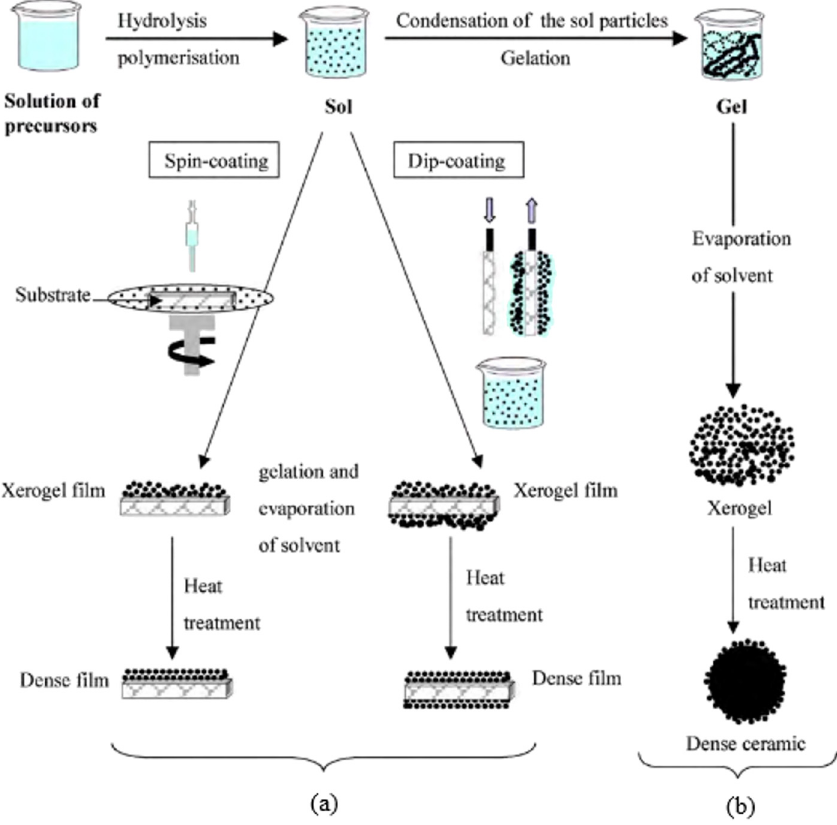
Figure 3: Two examples of synthesis of ZnO by sol – gel method: ( a ) fi lm of ZnO from colloidal solution and ( b ) powder form of ZnO from gel. Reproduced with permission from Elsevier [ 113 ]